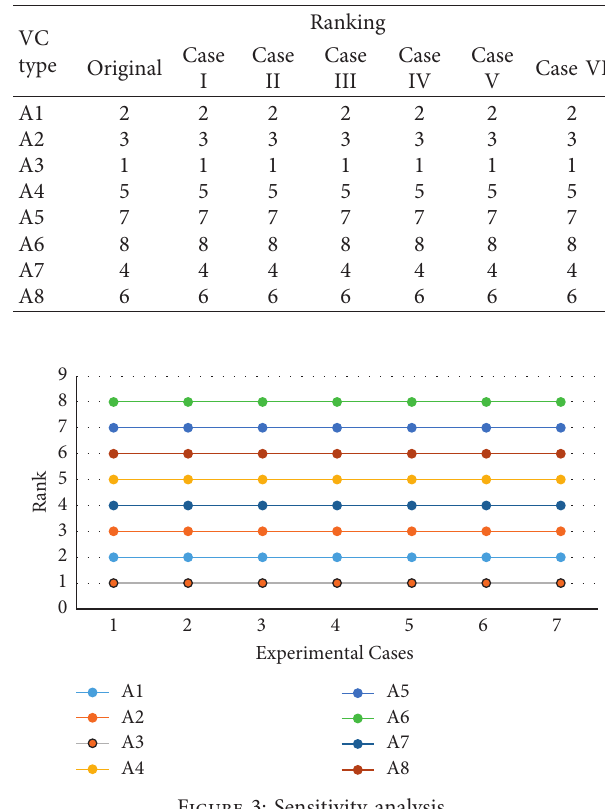
Table 17: Result of sensitivity analysis.